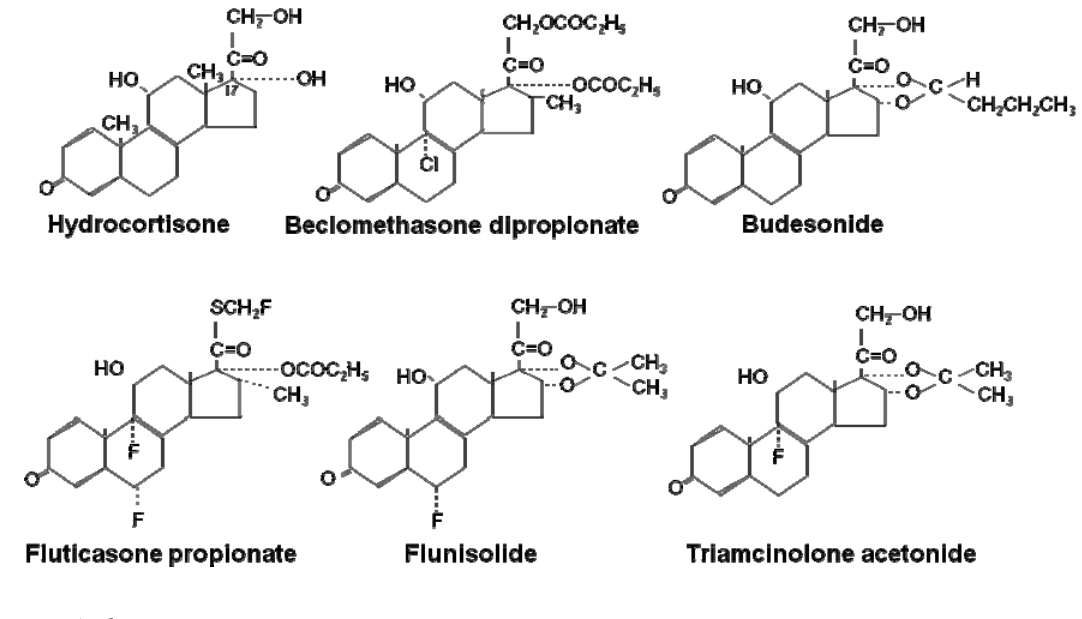
Figure 8. Chemical structures of inhaled